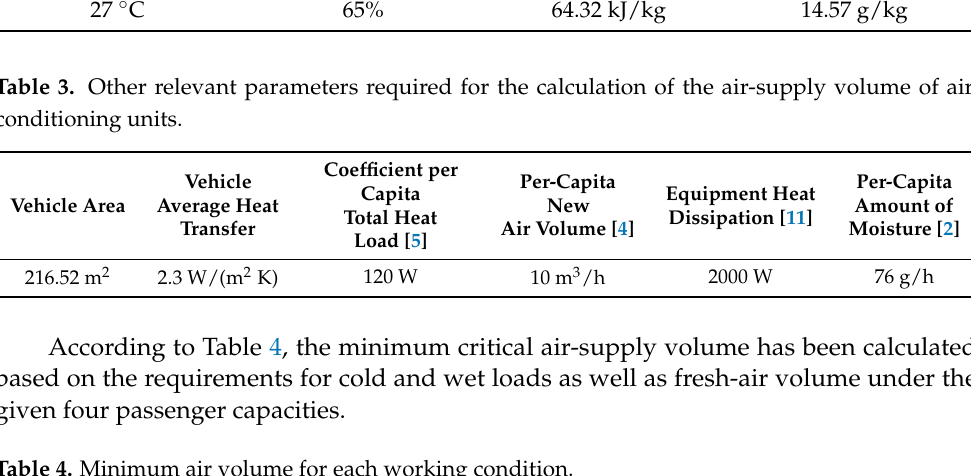
Table 4. Minimum air volume for each working